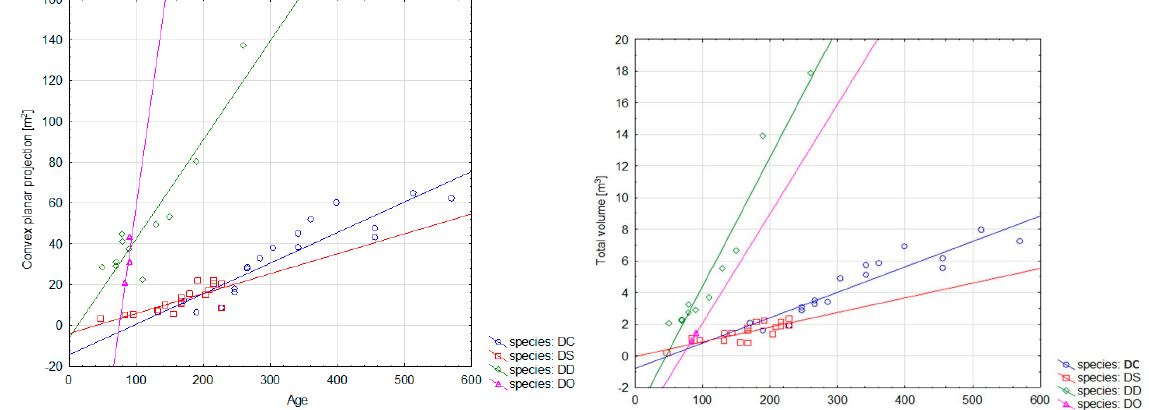
Figure 7. Convex planar projection compared to the stem diameter at breast height (DBH). Key: DC